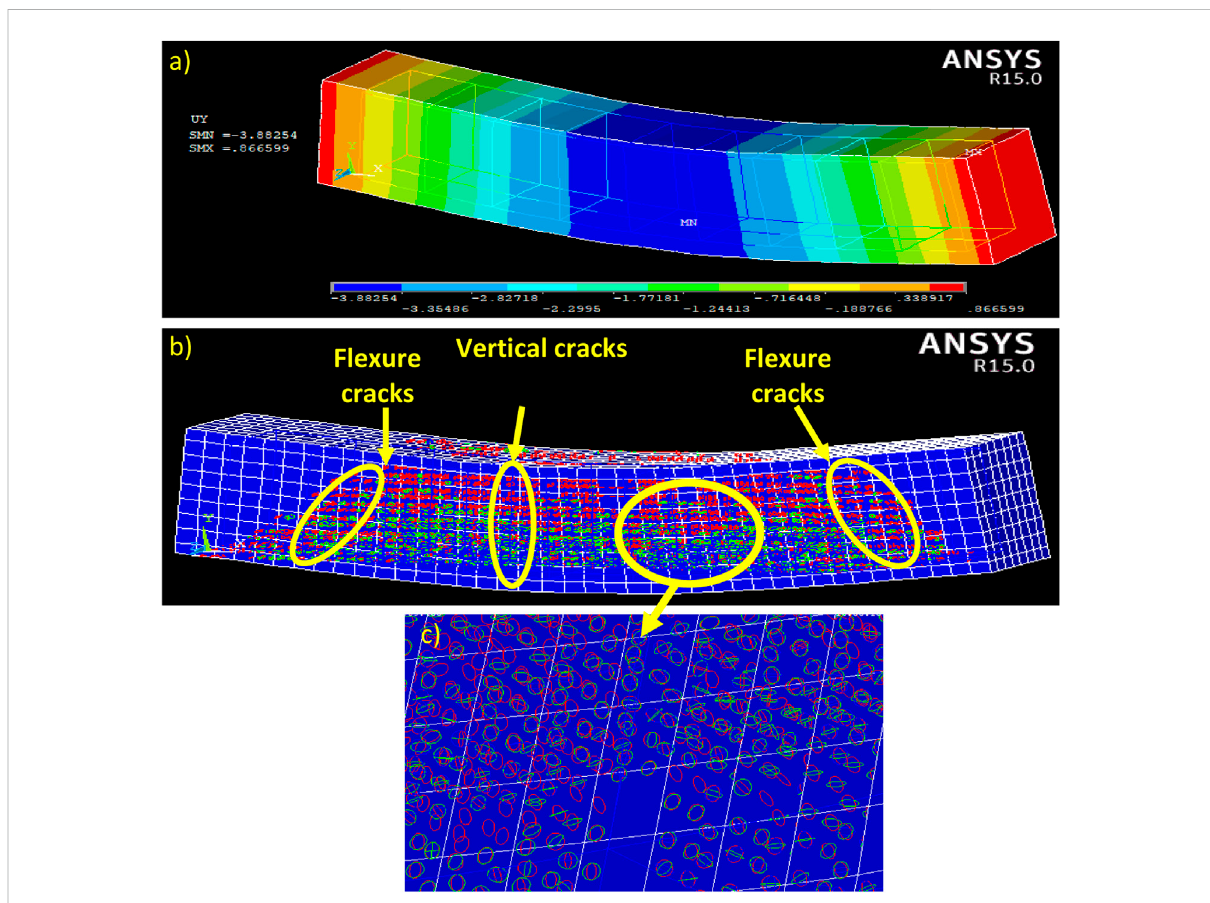
FIGURE 13 3D fi niteelementanalysisresultsforreferenceconcrete,consistingofacontourplot (A) ,animageofcracksintheRCB (B) ,andclose-upimages of cracks (C)